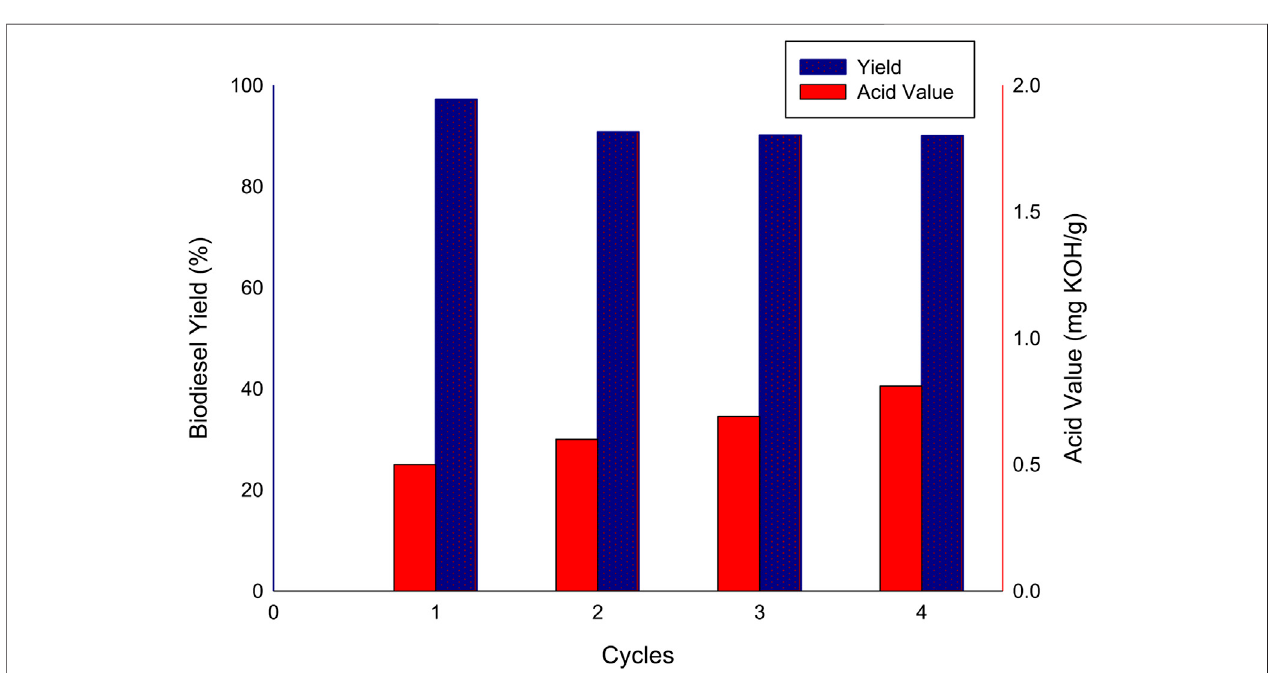
FIGURE 6 | Biodiesel yield and acid value after